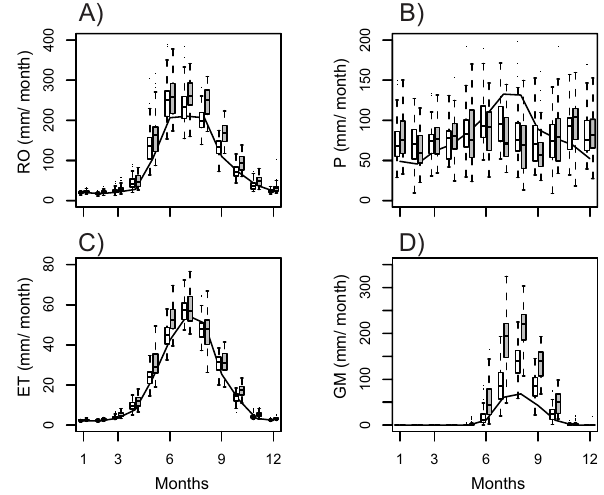
(B) precipitation ( P ), (C) evapotranspiration (ET) and (D) glacier melt (GM). The boxes including values from 2010 to 2055 are plot- ted in white, boxes including values from 2055 to 2099 are in gray. As reference values median monthly simulated areal values from 1993–2008 are plotted with a black line.